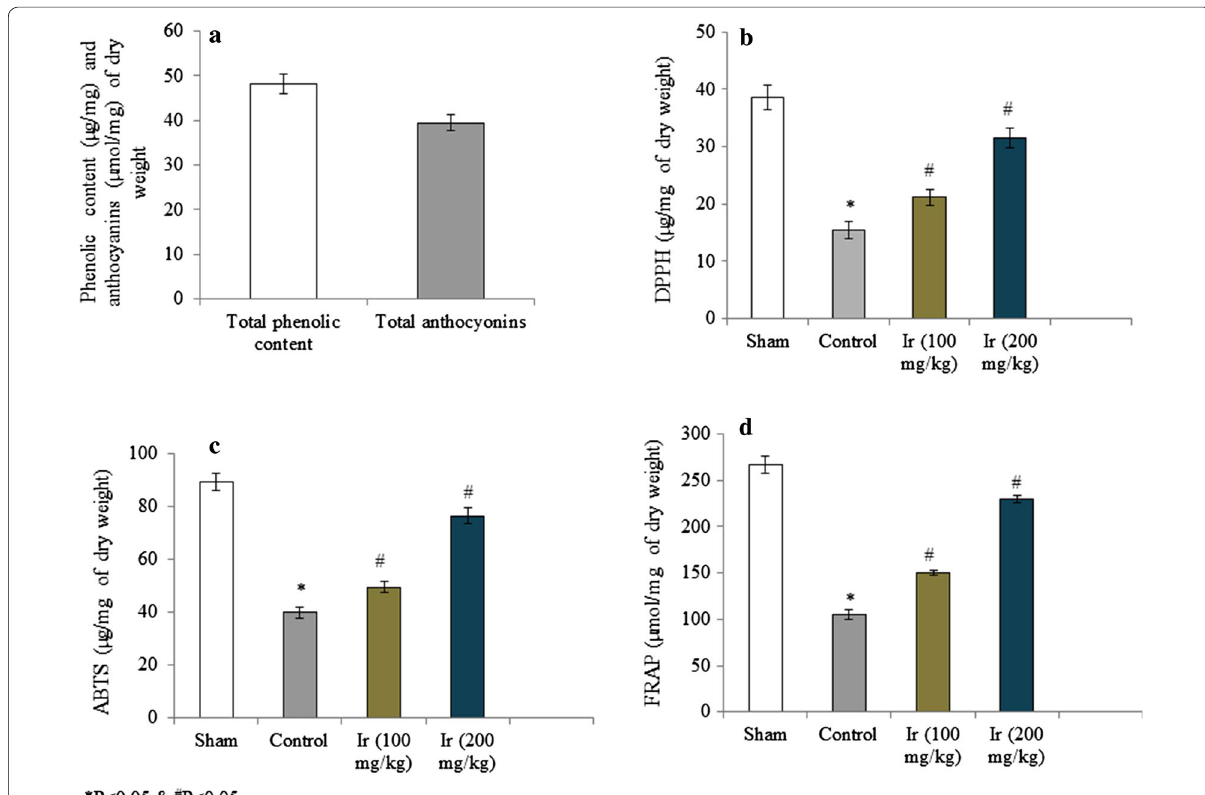
Fig. 1 Total phenolic and anthocyanins content in the extract of Ir ( a ). DPPH activity in control and treated rats ( b ). ABTS activity in control and treated rats ( c ). FRAP activity in control and treated rats ( d ). N